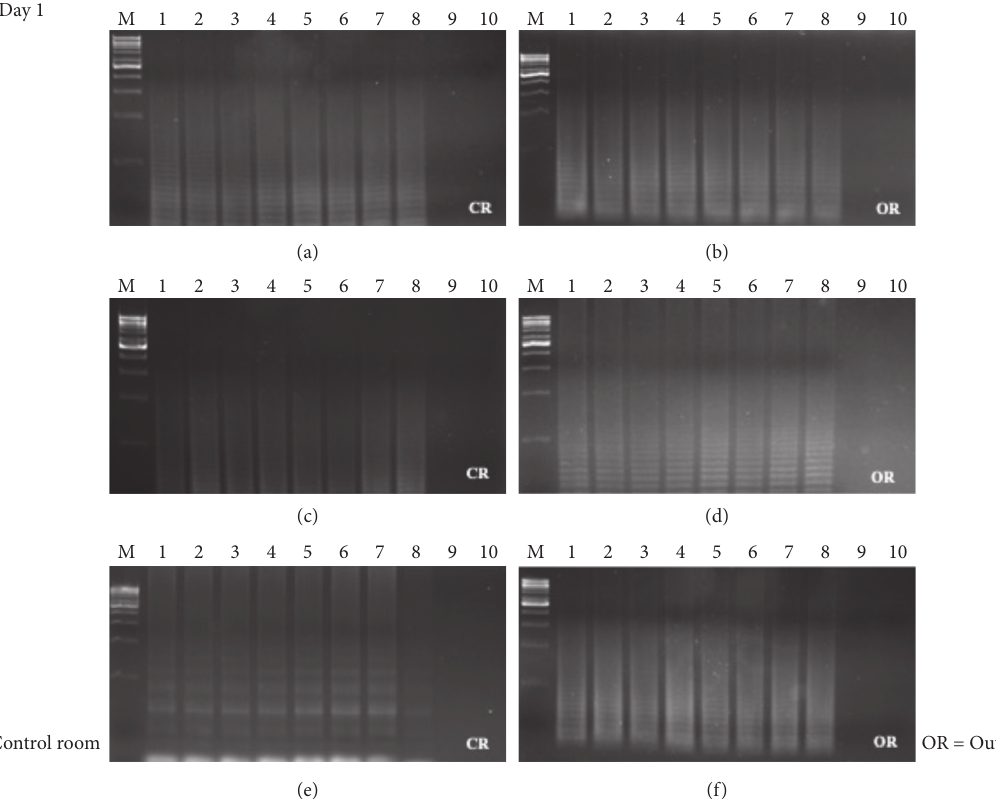
Figure 1: Time course detection of DNA sample stained on different surfaces in day 1. (a), (b) brick, (c), (d) cloth, and (e), (f) tile. M � 1kB DNA ladder, lane 1–9 � male sample 1–8, and lane 9, 10 � female sample